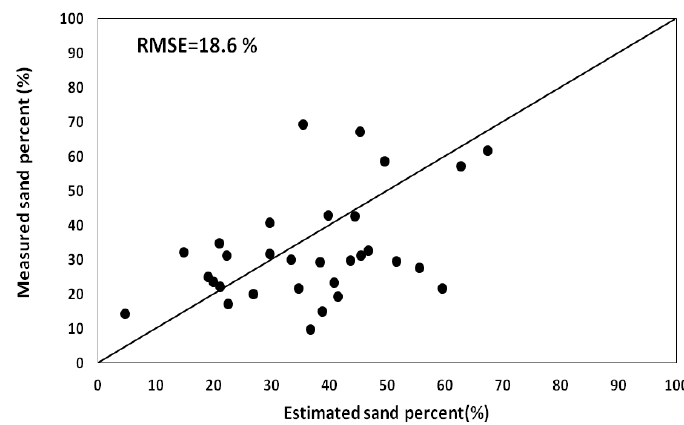
Figure 10. Comparison between estimated and ground truth measurements of sand content over 34 test fields.